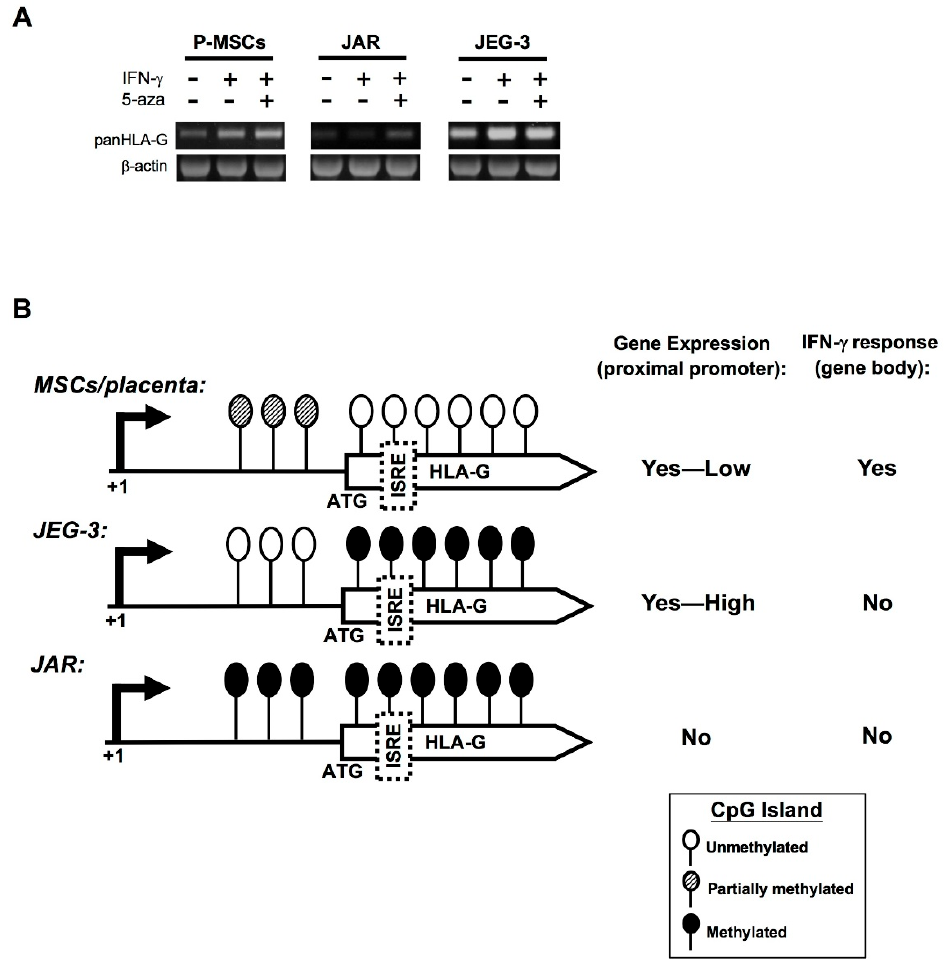
Figure 6. Demethylation with 5 ‐ azacytidine results in increased HLA ‐ G expression patterns in MSCs. ( A ) RT-PCR analysis of HLA-G gene expression in P-MSCs (donor 1), JAR cells, and JEG-3 cells, after treatment with IFN- γ (200 ng / mL) and / or the demethylating agent 5-azacytidine (5-aza; 10 µ m) after 24 h. ( B ) Proposed model of epigenetic regulation of HLA-G transcription in human MSCs and choriocarcinoma cell lines JEG-3 and JAR. Schematic representation of the unmethylated (white circles), partially methylated (striped circles), and methylated CpG sites (black circles) on the HLA-G proximal promoter and gene body in normal cells / tissue as represented by human MSCs and term placenta tissue, compared to the 2 choriocarcinoma cell lines JEG-3 and JAR, as correlated to HLA-G expression levels and IFN- γ responsiveness. ISRE (putative), interferon-stimulated response element; ATG, translation initiation site.